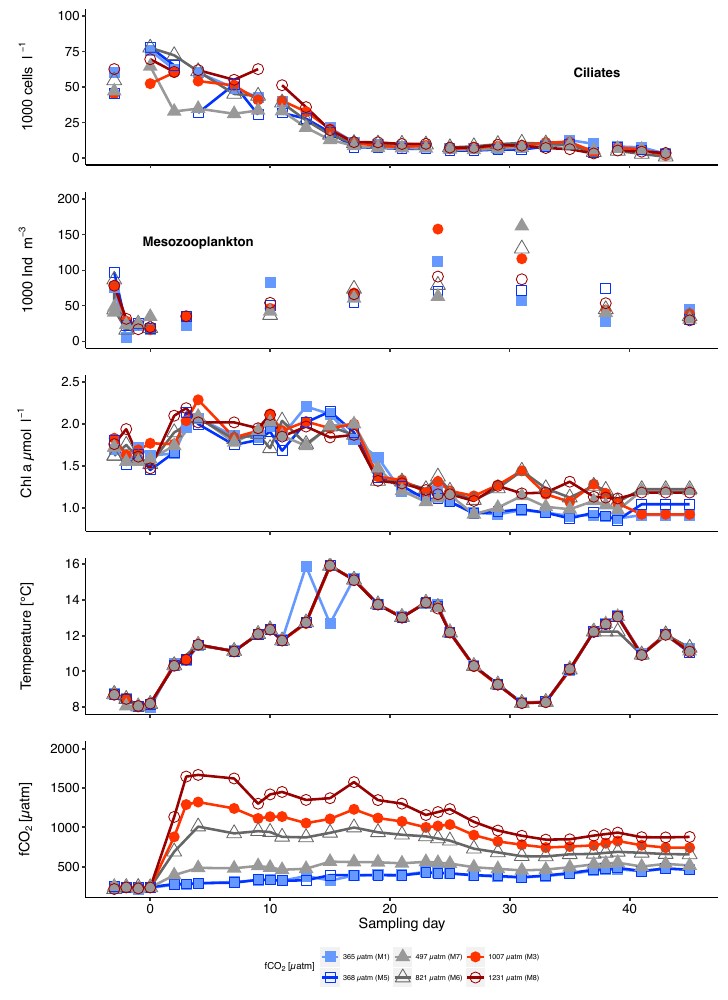
Figure 1. Total cell numbers of ciliates and total abundance of mesozooplankton during the course of the experiment as well as chlorophyll a succession, temperature, and f CO 2 development. According to temperature variations and the first CO 2 manipulation, different experimental phases were defined: phase 0 = t − 5 to t 0 , phase I = t 1 to t 16 , phase II = t 17 to t 30 , phase III = t 31 to t 43 . Note that there is one missing value in M1 on t 13